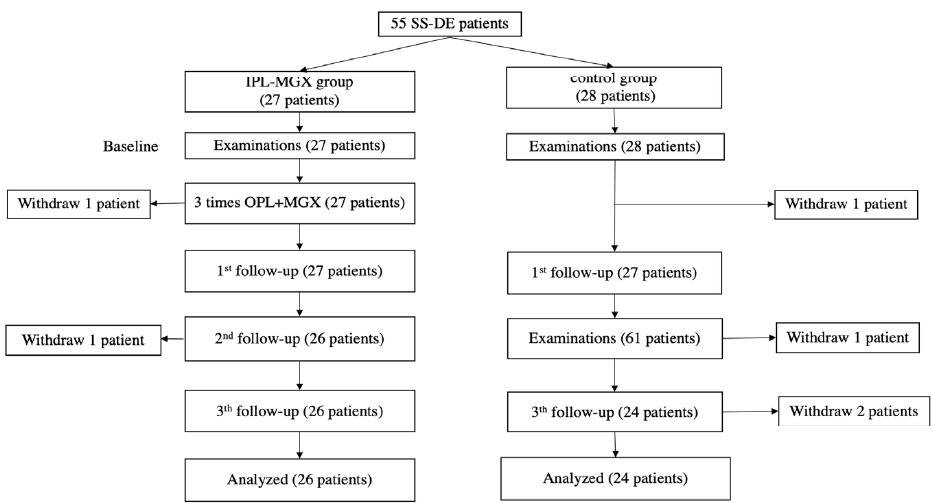
Figure 1. The treatment protocol and follow-up schedule for the intense pulsed light (IPL)-meibomian gland expression (MGX) and control groups are presented. Table 1. Characteristics of the study subjects in the intense pulsed light (IPL)-meibomian gland expression (MGX) and control